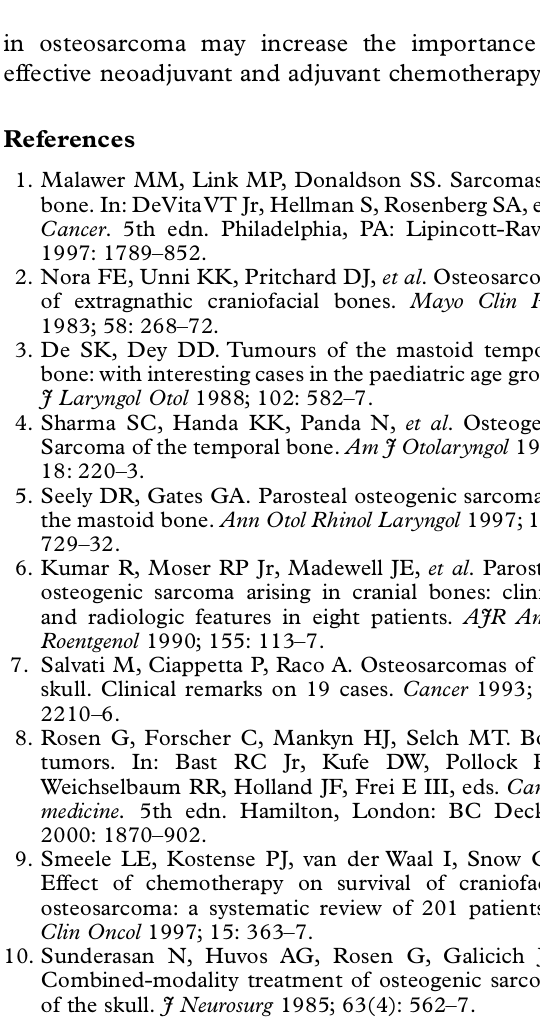
Fig. 2. Histopathological examination of the mass in mastoid bone demonstrated many eosinophilic lace-like osteoid accumulations with atypical osteoblasts surrounding them HE